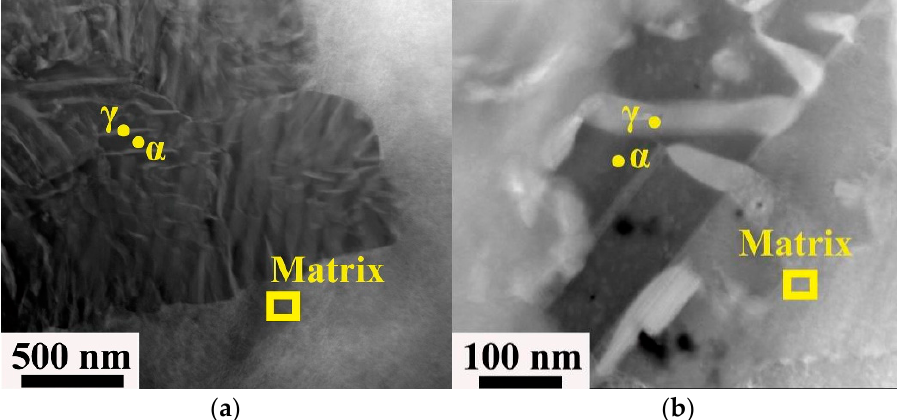
Figure 8. STEM image of a cold-rolled alloy Cu–15Ni–8Sn–xFe: ( a ) x = 0; ( b ) x = 0.5